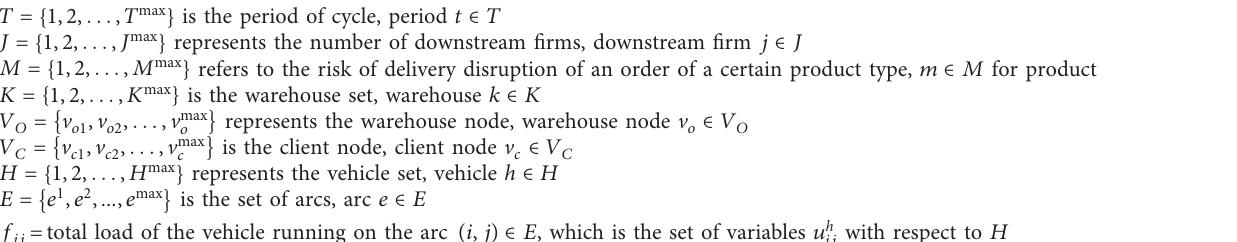
Table 1: Set description of discrete supply networks.